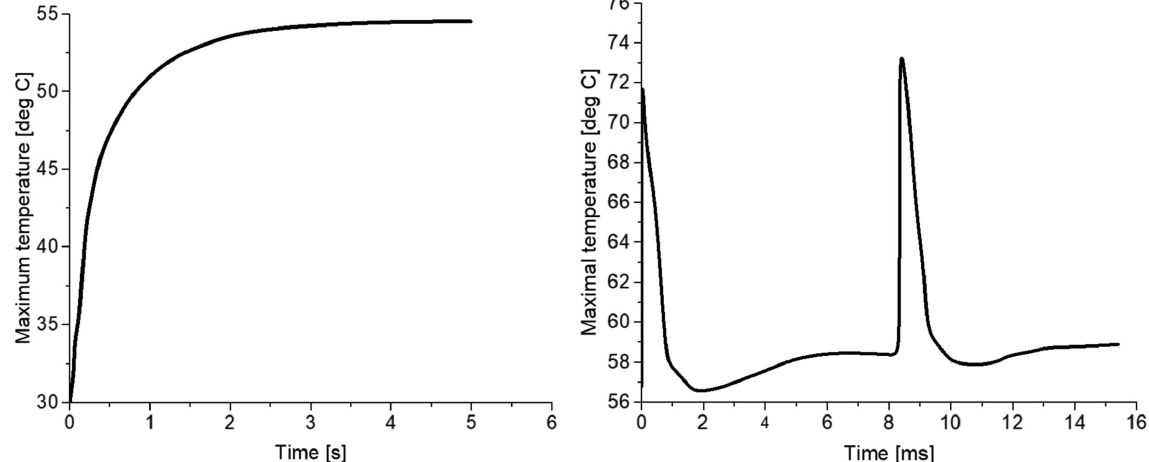
18. Transient temperature analysis results. Left: in large time scale. Right: with rf pulse resolution. The results are taken at the point with the maximal